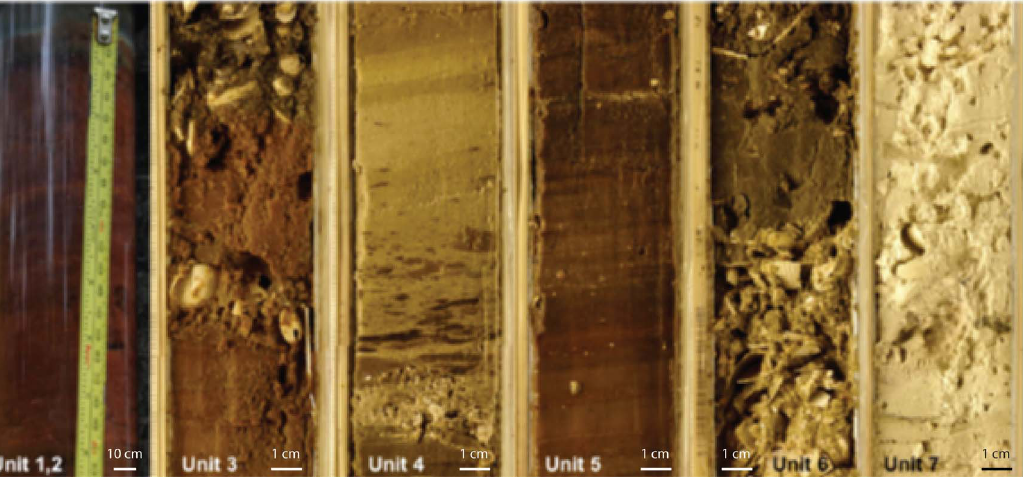
Figure 7. Lib Pond Sediment Unit Examples. Representative images of distinct stratigraphic units observed in sediment cores, Units 1–7. Unit 1 and 2 appear in the same image. Unit 1 is the 1–2 cm green layer above the underlying red material, Unit 2. Relative scales have been added to show how much real-world space each image represents.